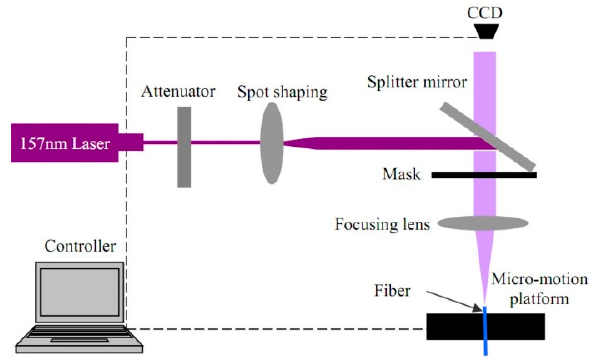
Figure 2. Schematic of micromaching system based on 157-nm excimer laser.